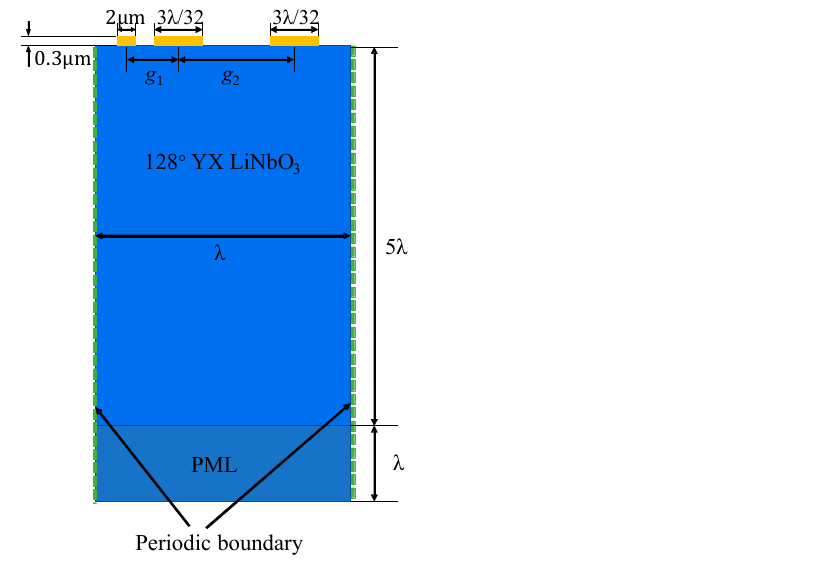
Figure 4. Optimized model of an EWC-SPUDT structure unit.